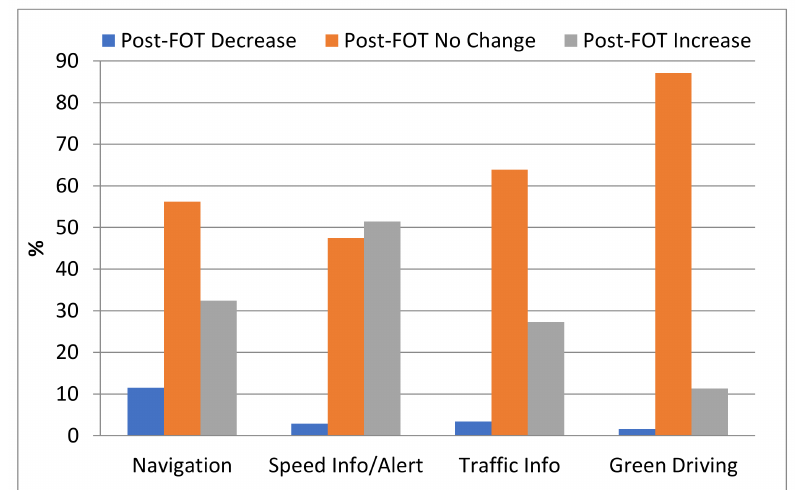
Figure 6. Post-FOT: perceived safety impact per